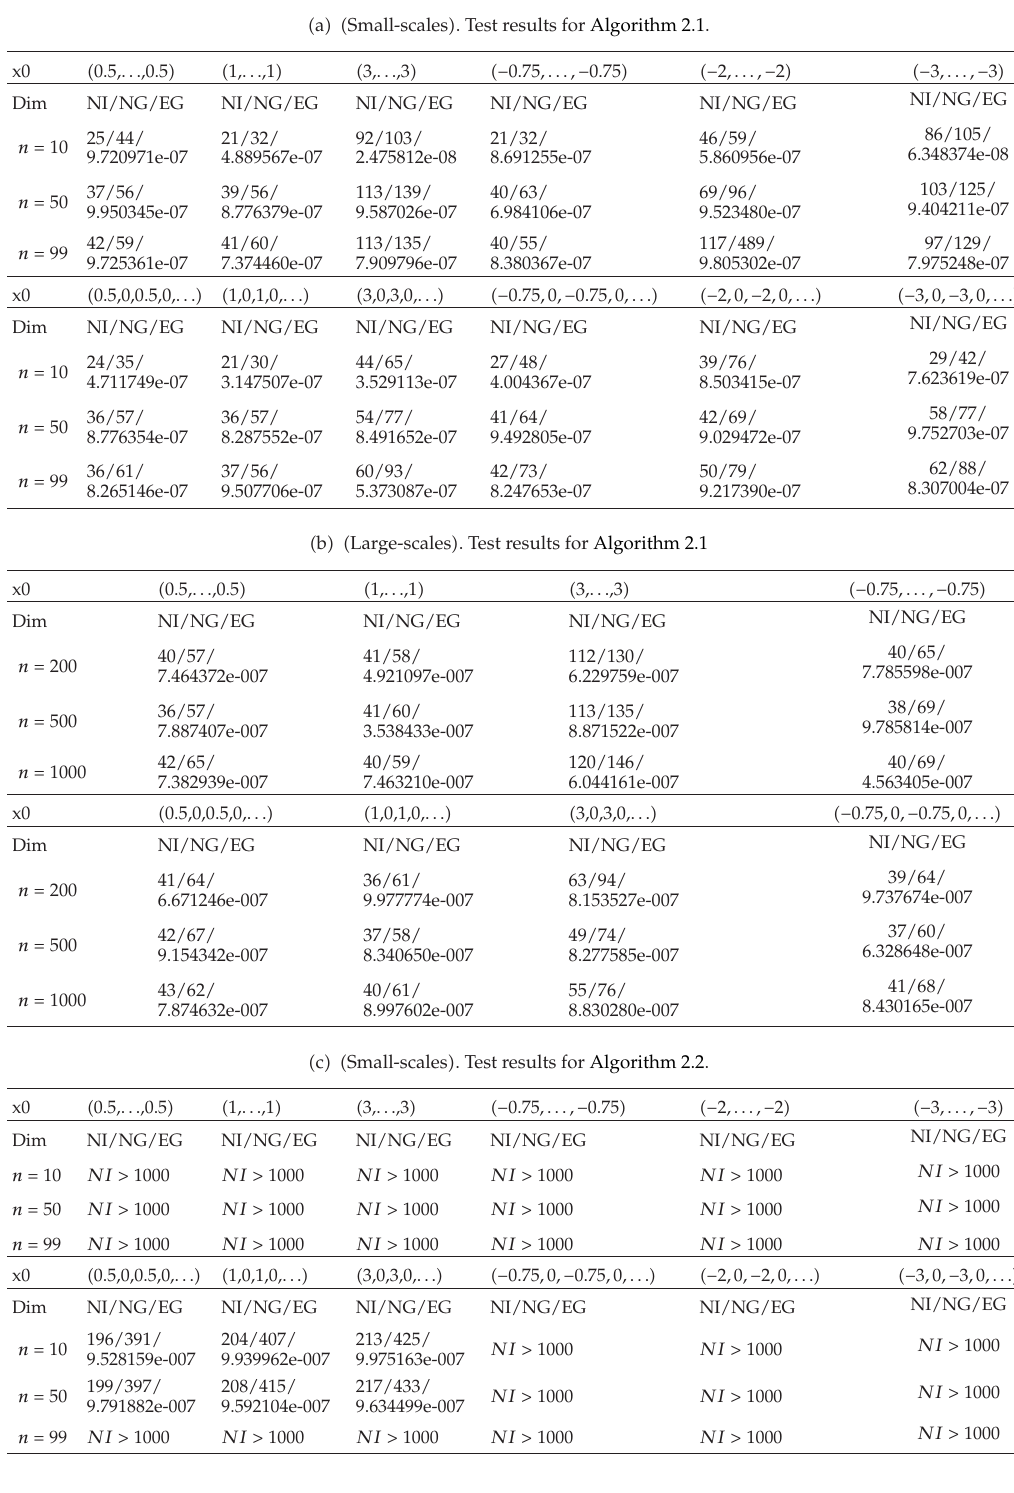
Table 2: Test Results For Problem